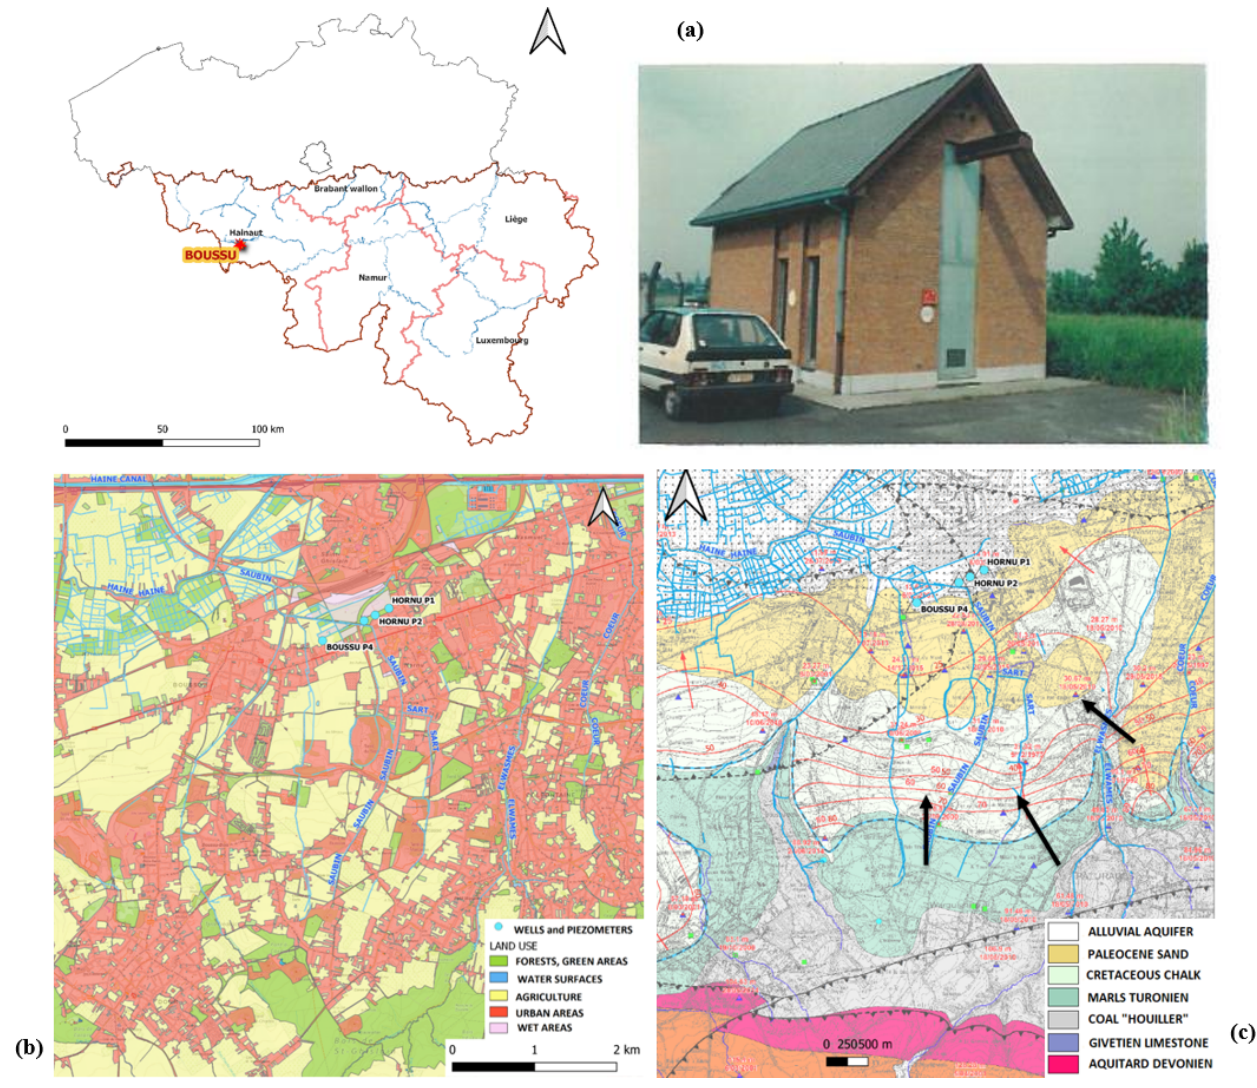
Figure 3. (a) Localisation, (b) land use (source: © WalOnMap), and (c) hydrogeological map of the study area (background map: Carte Quiévrain –